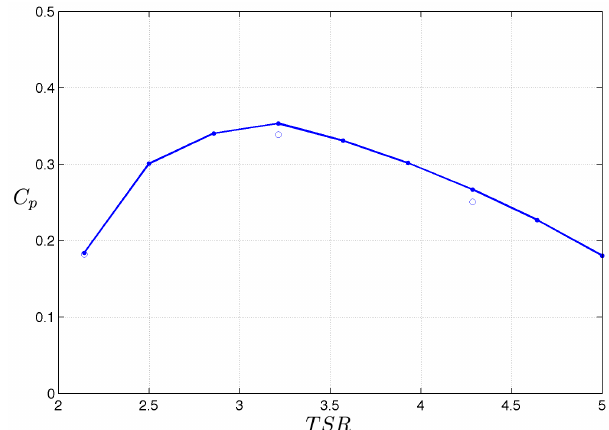
Figure 2. H-type VAWT with AR = 1 . 5: power coefficient curve obtained at intermediate resolution ( D/h = 48, solid line) and con- figurations investigated at high resolution ( D/h = 96,